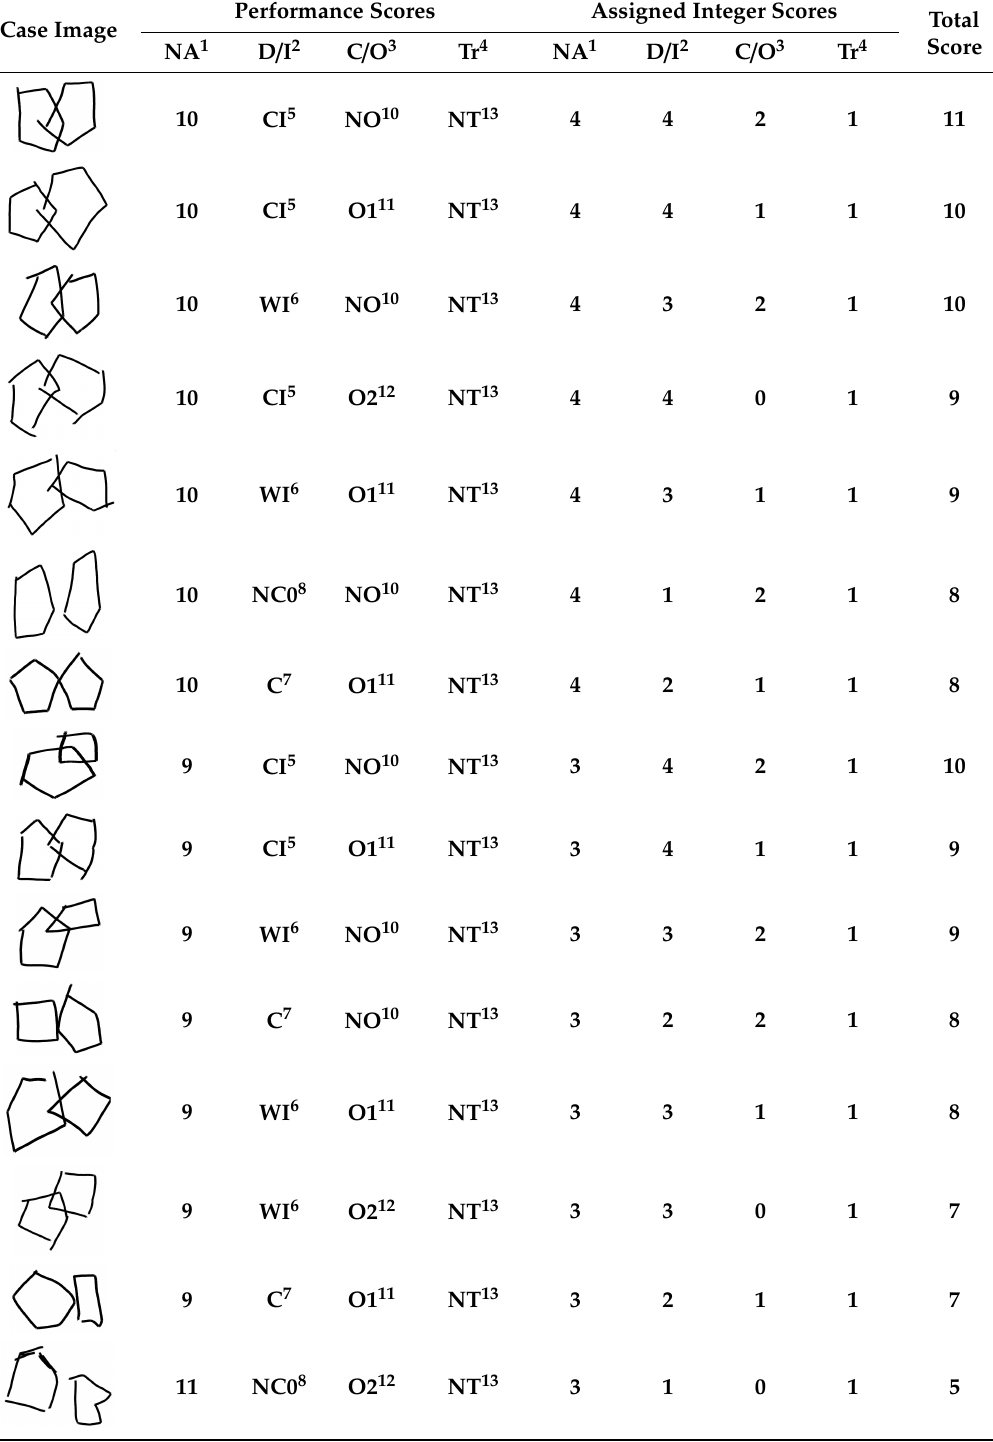
Table A2. Examples of corresponding drawings and scores for each level with the corresponding detailed parameters.